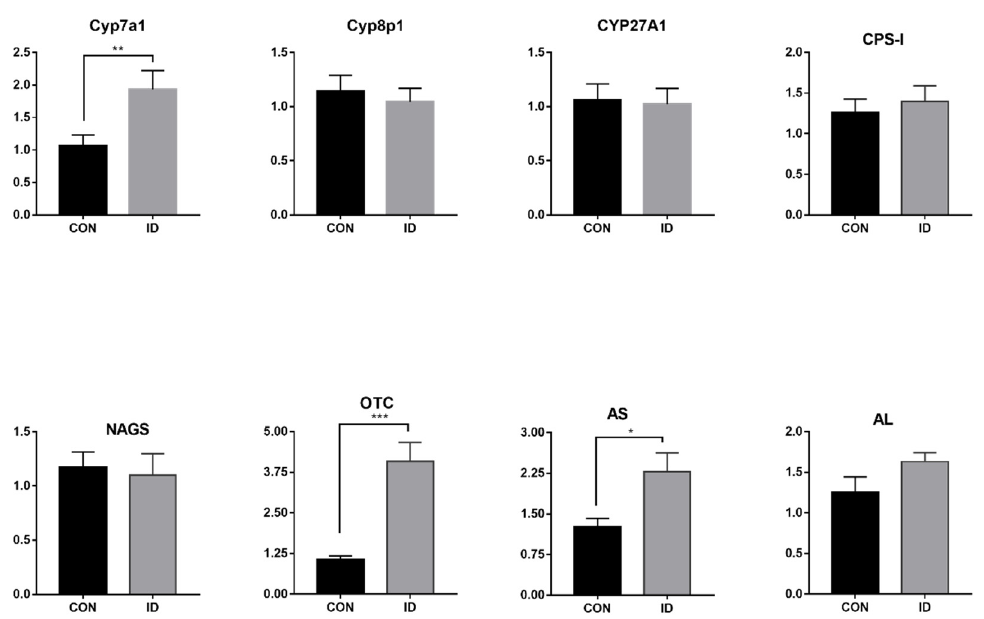
Figure 4. mRNA expression of genes related to the enzymes of hepatic bile acids synthesis and urea cycle in piglets with or without iron supplementation. Cyp7a1, cholesterol 7 α -hydroylase; Cyp8p1, Sterol 12 α -hydroxylase; CYP27A1, sterol 27 hydroxylase; CPS-I, carbamyl phosphate synthetase I; OTC, ornithinetranscarbamoylase; NAGS, N-acetylglutamate synthase; AS, argininosuccinate synthetase; AL, argininosuccinase lyase. * indicates statistical significance, p < 0.01, ** indicates statistical significance, p < 0.05, *** indicates statistical significance, p < 0.001.